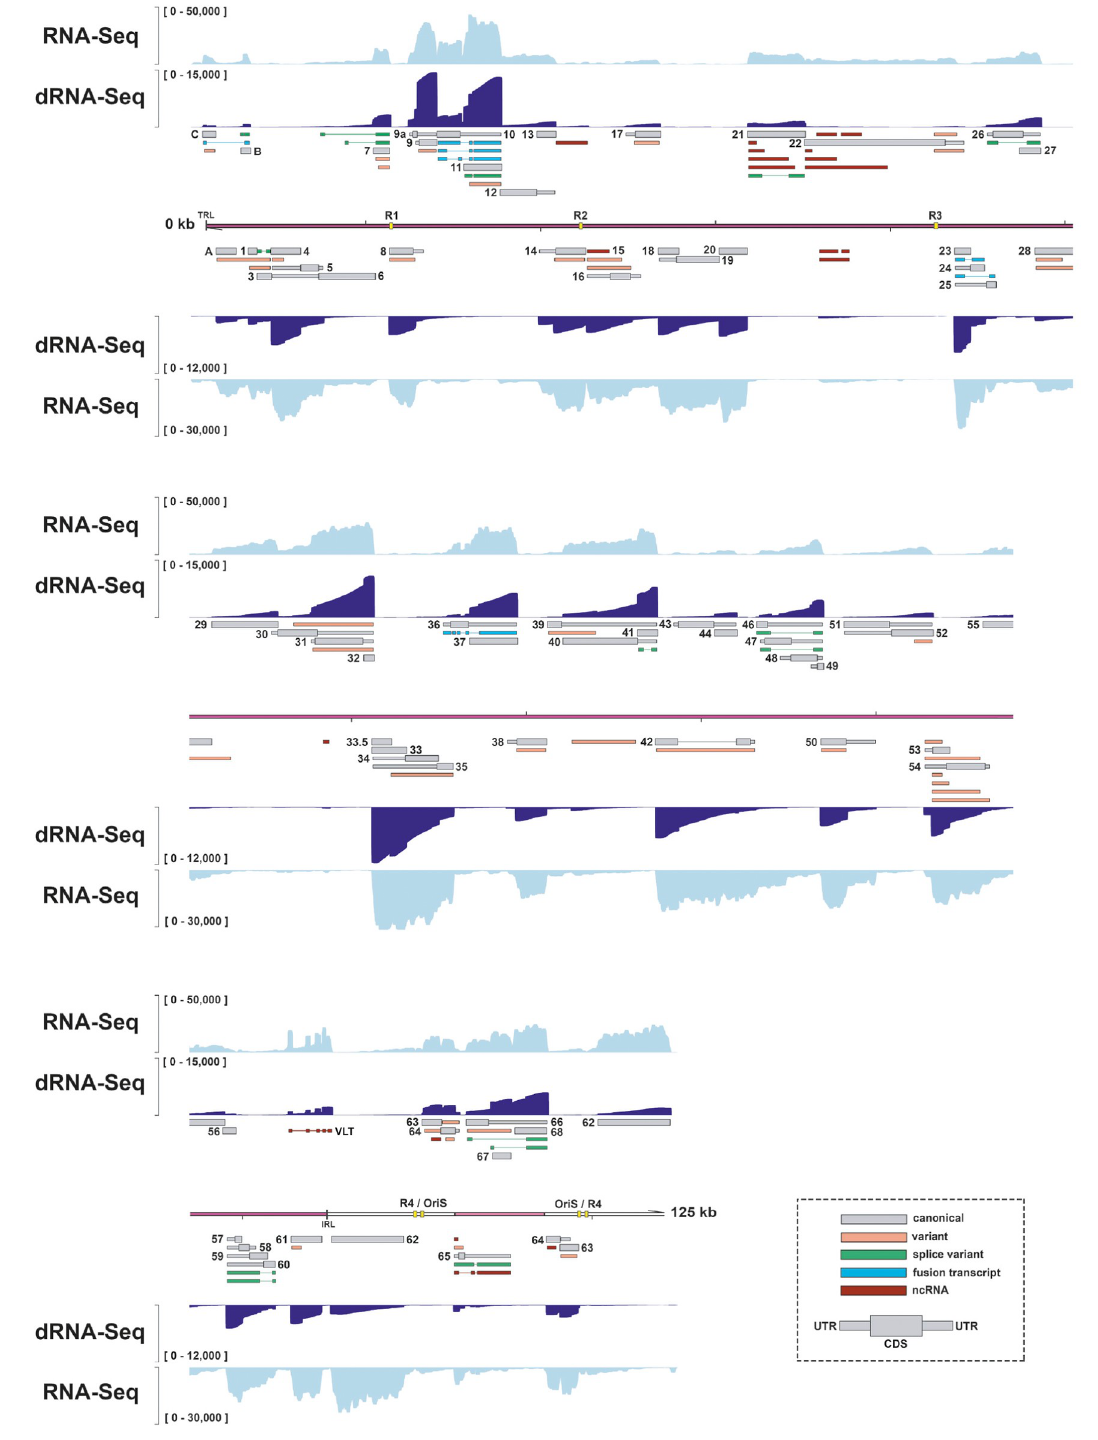
Fig 1. Reannotation of the lytic SVV transcriptome in BS-C-1 cells. The reannotated lytic SVV transcriptome consists of 150 RNAs, 73 of which encode canonical ORFs with UTRs (thin box) and CDS (wide box) indicated in grey, 34 variants RNAs (orange), 15 splice variants (green), 7 fusion transcripts (blue) and 21 putative non-coding RNAs (red). Shown are Illumina RNA-seq (light blue) and nanopore dRNA-seq (dark blue) coverage plots of BS-C-1 cells lytically infected with SVV strain Delta for 96 hours. Maximum read depth per track is given on the Y-axis. Double black lines represent the SVV genome, with the long unique region (UL) in purple fill, short unique region (US) in pink and internal/terminal repeat sequences (IRS/TRS) no fill, ticks indicate 10 kb intervals and the reiterative repeat regions R1 to R4 and both copies of OriS are indicated as yellow boxes on the genome track. https://doi.org/10.1371/journal.ppat.1010084.g001 PLOS Pathogens| https://doi.org/10.1371/journal.ppat.1010084 November 22,